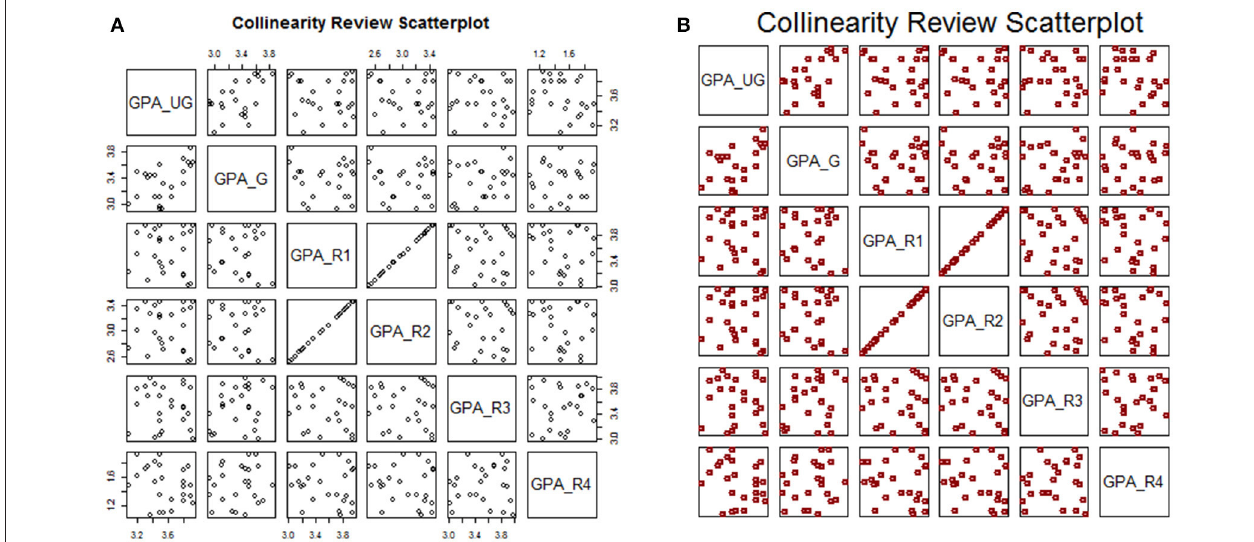
FIGURE 3 | Default plot (A) and modified plot (B) of multi-variate scatterplots for assessing collinearity.